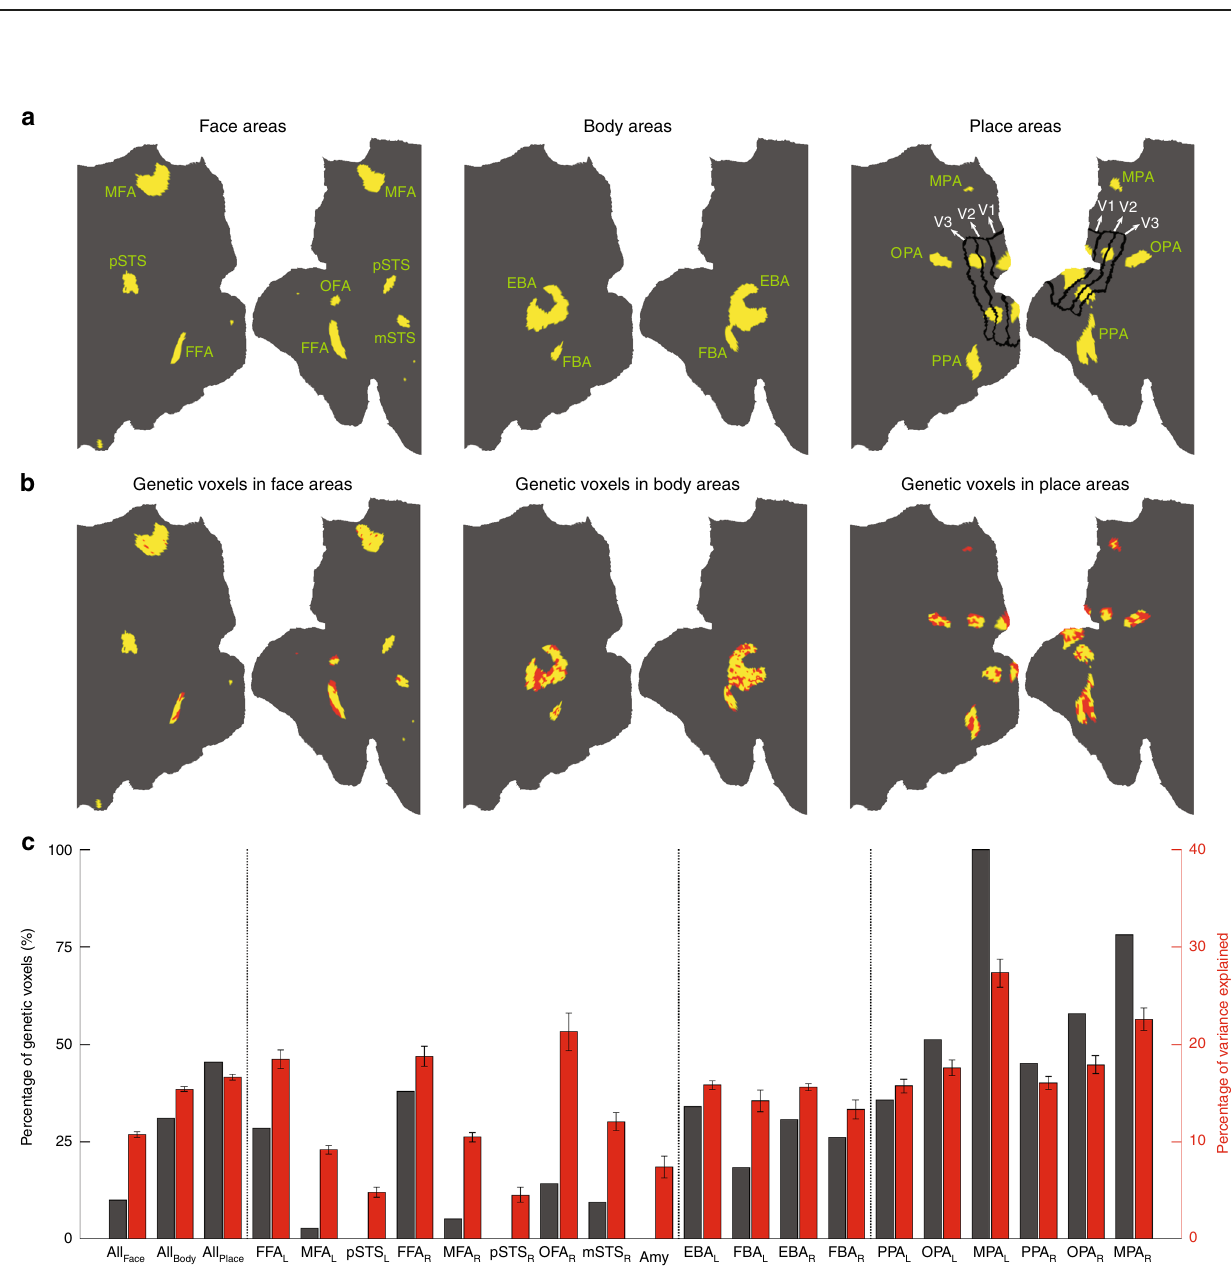
Fig. 1 Correlation between category-selective activations in MZ and DZ twins. a For each category, ICC maps in MZ and DZ twins are displayed on a 2D fl at patch of left and right hemispheres (left and right maps in each subpanel). b Left panel: A schematic diagram depicting the procedure for computing Pearson ’ s r correlation. In each twin pair, the activation patterns ( z maps) of one twin and the co-twin were correlated. In the activation vector, data from two hemispheres were concatenated. Right panels: Distribution of correlation coef fi cient values for all MZ and DZ twin pairs in face-, body-, and place- selective maps. c Mean correlation was calculated separately for each cortical lobe (O occipital, P parietal, T temporal, F frontal). Lobar parcellation was based on PALS-B12 atlas of human cerebral cortex 55 (http://brainvis.wustl.edu/wiki/index.php/Caret:Atlases). Error bars represent one standard error of the mean, here and in the other fi gures. * p < 0.05, ** p < 0.005, *** p < 0.0005; Bonferroni-corrected pooled t test for three comparisons in panel ( b ) and 12 comparisons in panel ( c ).